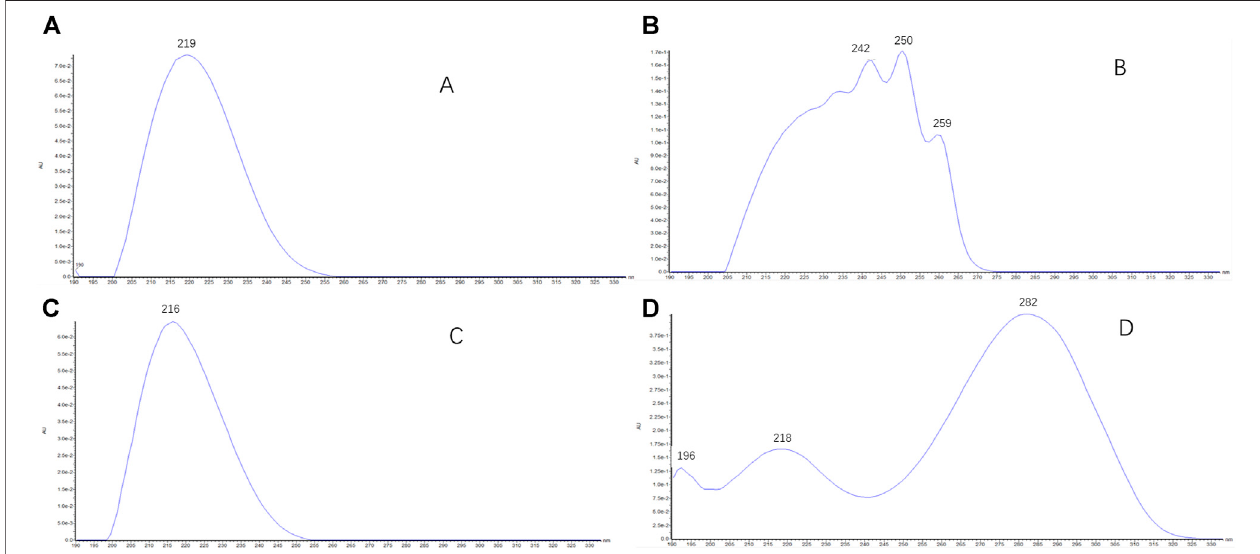
FIGURE 8 | UV spectra of saikosaponins (type I-IV): (A) the representative UV spectra (190 – 220 nm) of type I saikosaponins; (B) the representative UV spectra (around 250 nm) of type II saikosaponins; (C) the representative UV spectra (190 – 220 nm) of type III saikosaponins; (D) the representative UV spectra (around 282 nm) of type IV